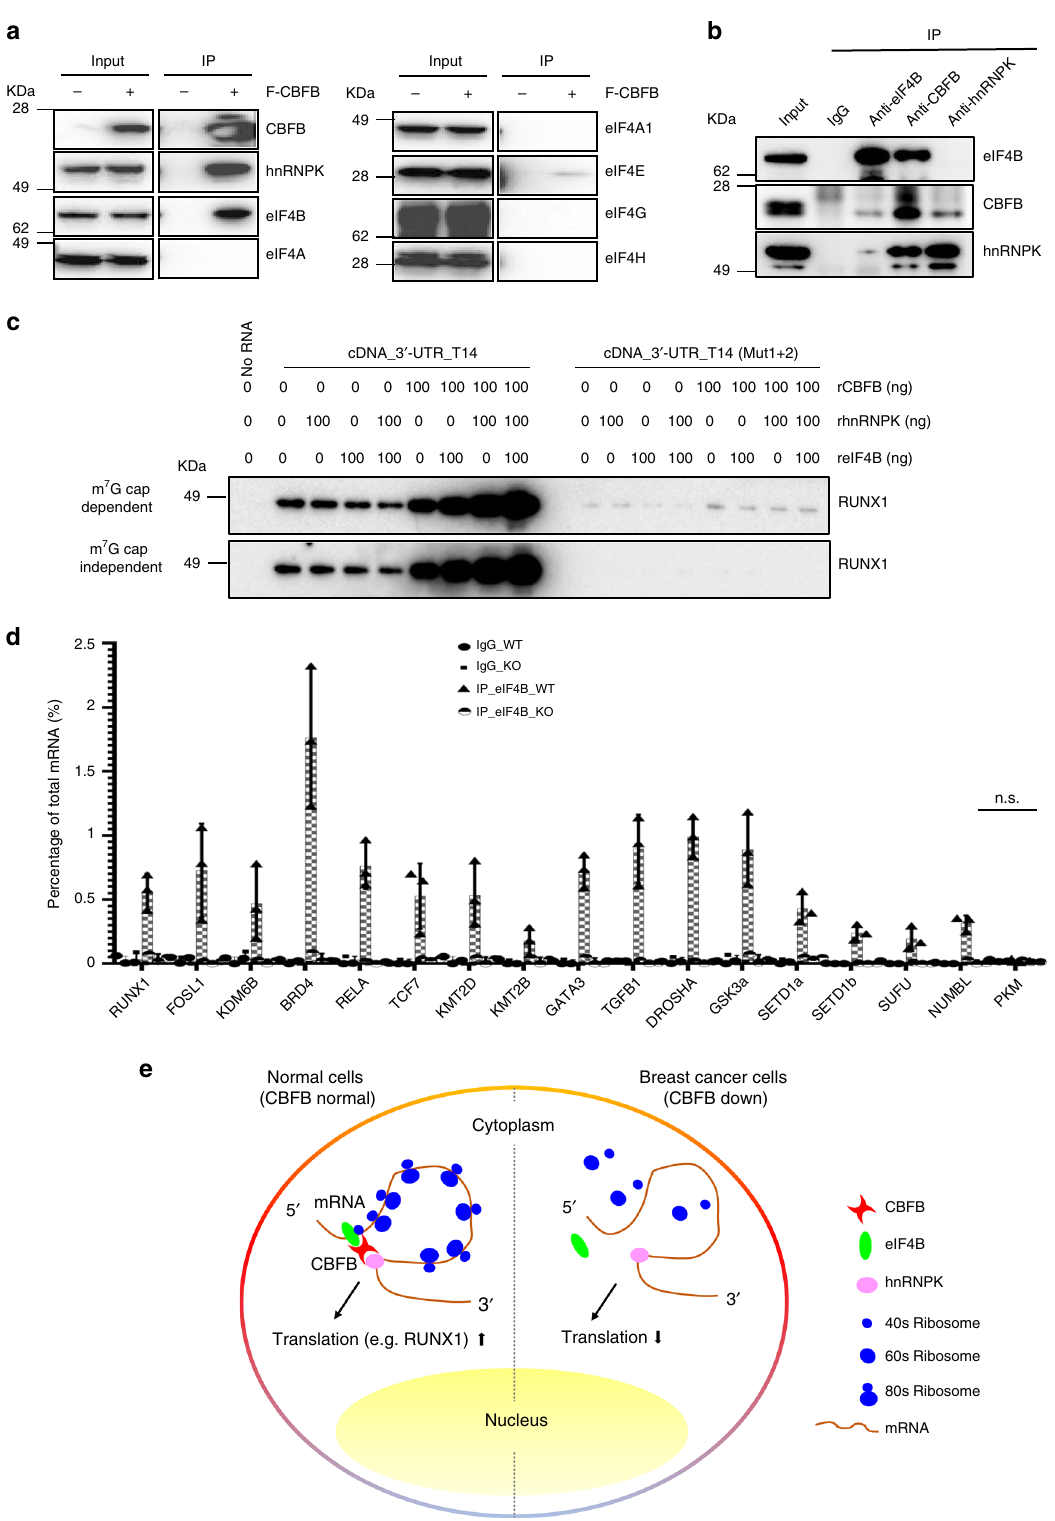
Fig. 6 CBFB interacts with and facilitates mRNA binding of eIF4B. a FLAG IP followed by IB showing the interaction of translation initiation factors with CBFB. 10 µ g/ml RNase A was added in the co-IP lysate. b Endogenous co-IP followed by IB showing interaction of CBFB, hnRNPK, and eIF4B. 10 µ g/ml RNase A was added in the co-IP lysate. c In vitro translation assays showing the effect of rCBFB, rhnRNPK, and reIF4B on RUNX1 translation in a cap- dependent or -independent manner. d RIP followed by real-time PCR to show the effect of CBFB deletion on the binding of eIF4B on CBFB-bound transcripts. Error bars are SEM, n = 3 (biological); n.s., p value > 0.05 (RIP of eIF4B in WT vs. CBFB KO cells). e A model showing the role of CBFB in translation regulation through hnRNPK and